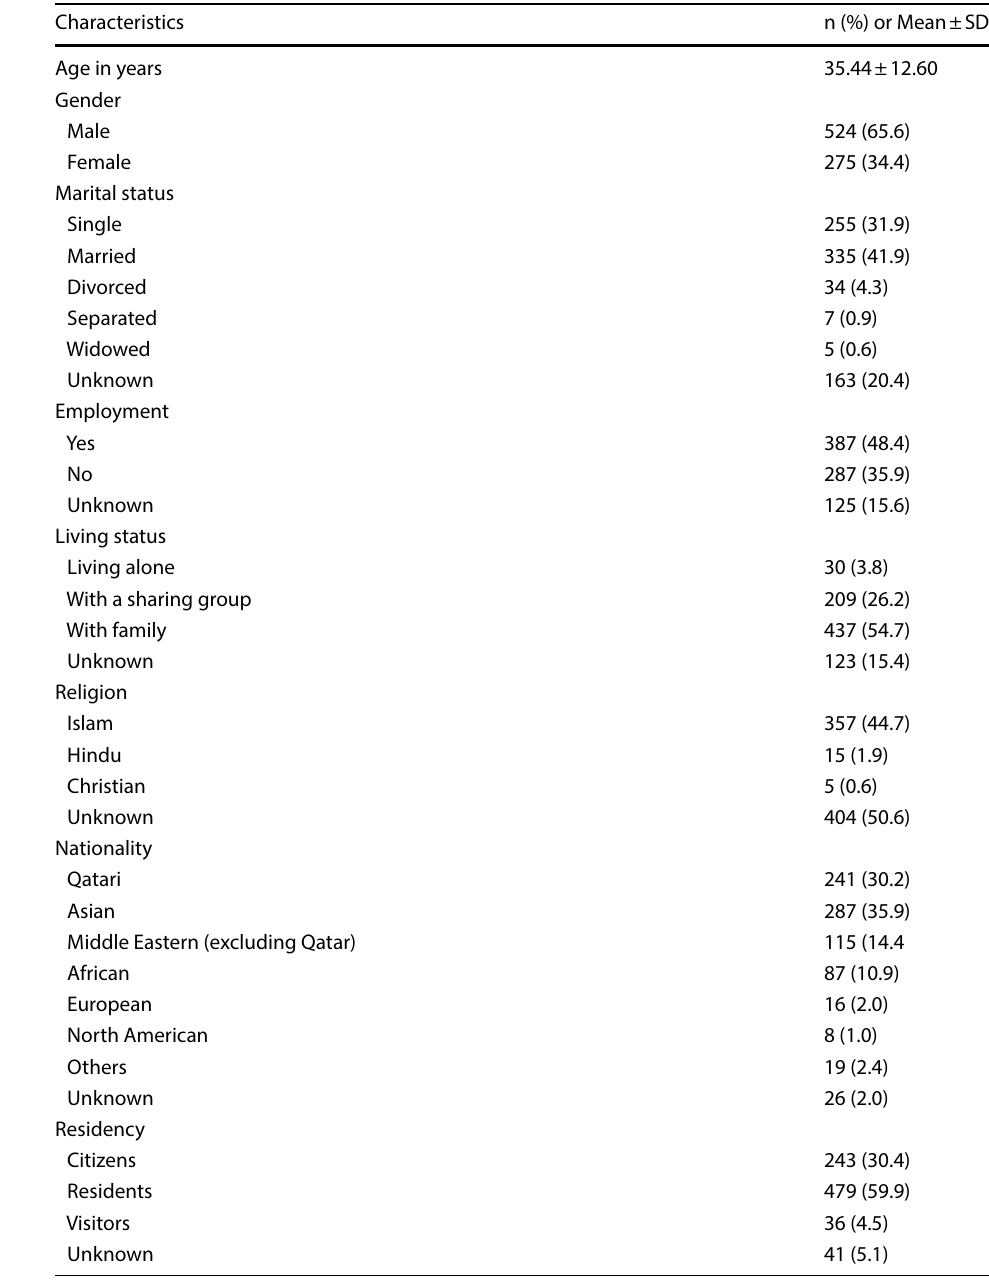
Table 1 Demographic characteristics of the study sample (N = 799)